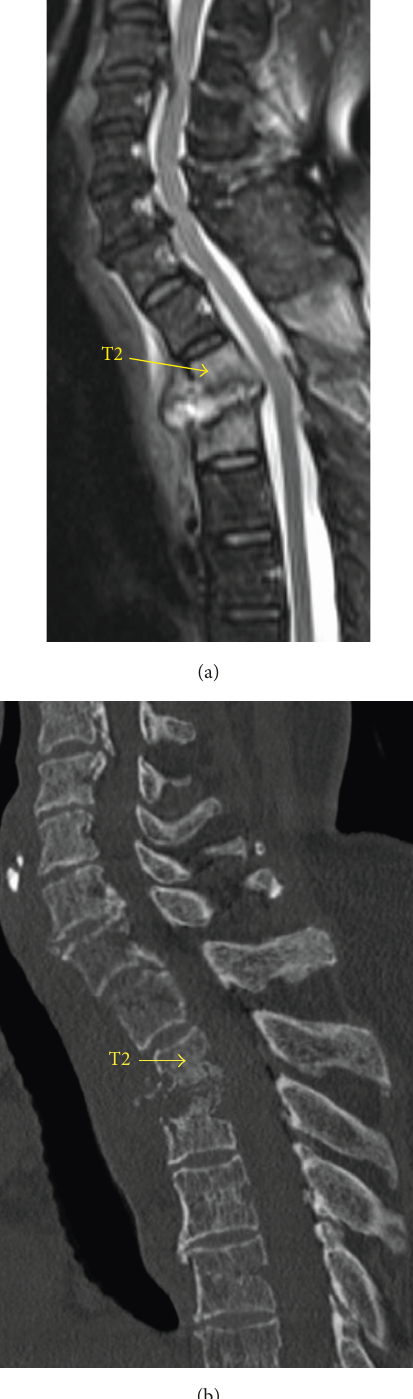
Figure 1: (a) Preoperative sagittal T2-weighted magnetic reso- nance image of the cervicothoracic spine shows vertebral osteo- myelitis and intervertebral disk abscess of T2/3. (b) Preoperative sagittal CT shows bone destructions of the endplates of T2/3.